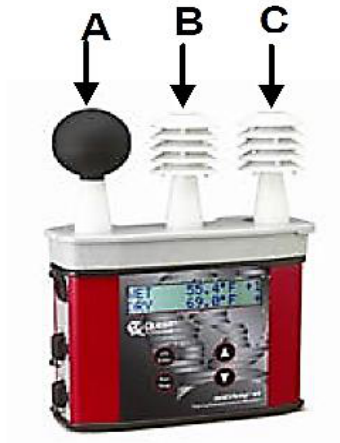
Figure 3. QUEST Temp 44 / 46 TM gauge-sensors identified: A is Globe thermomether, B is Relative humidity sensor and C is Dry bulb thermomether. Note: Mentioning the accuracy of the sensors used: Sensor Types: Temperature: 1000 ohm platinum Resistance Temperature Detector RTD, Humidity: Integrated circuit with capacitive polymer sensor Accuracy, Dry Bulb and Globe Temperature: +/ − 0.5 ◦ C between 0 ◦ C and 120 ◦ C, Waterless Wet Bulb Temperature: Expanded measurement uncertainty of 1.1 ◦ C (k = 2) between 0 ◦ C and 80 ◦ C, Relative humidity: +/ − 5% between 20 to 95% (non-condensing), Operating Temperature Range Sensor Assembly: − 5 ◦ C to + 100 ◦ C Electronics: − 5 ◦ C to 60 ◦ C.